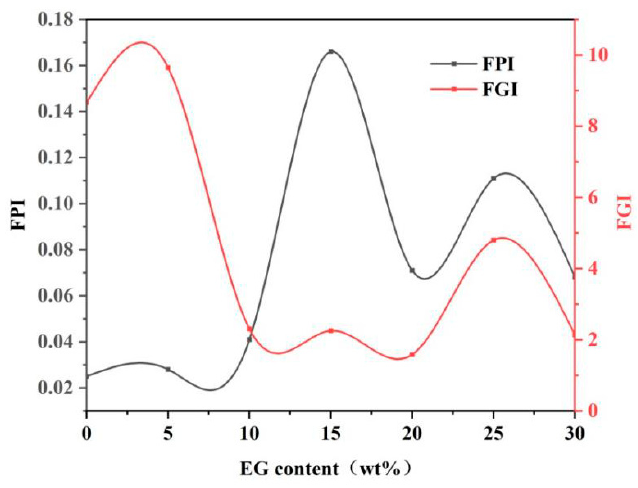
Figure 13. FPI and FGI curves of